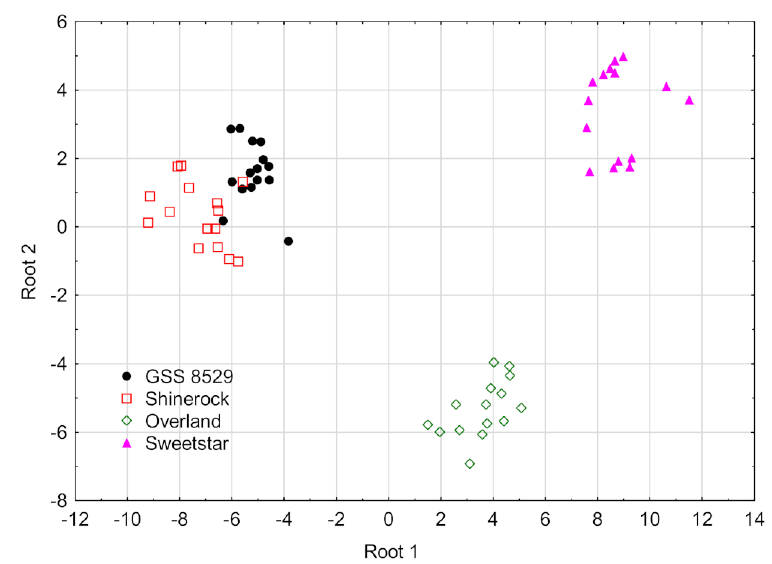
Figure 3. GDA classification of the scores (maize cultivars) based on tocopherols/tocotrienols and fumonisins contents.